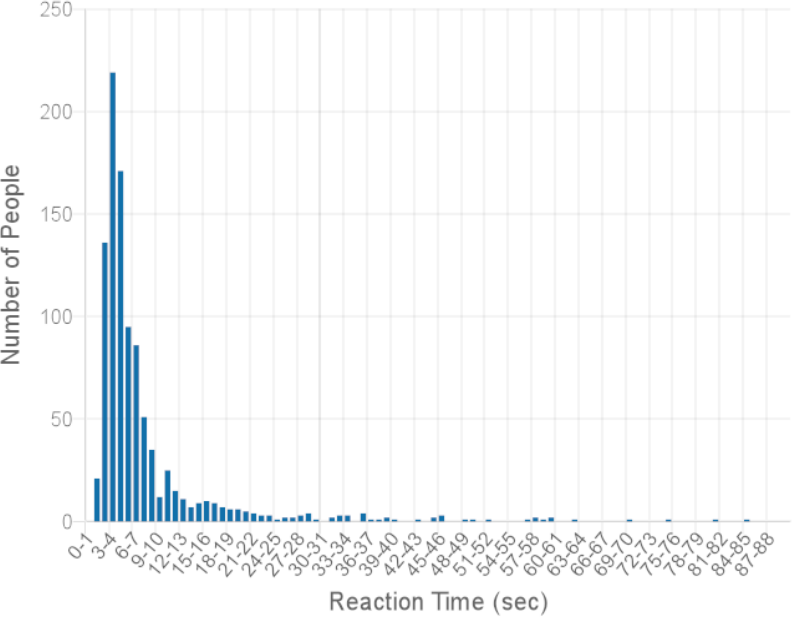
Figure A5. Reaction time distribution for Mobile Device category, question PQ610. Missing values in the histogram: 4.